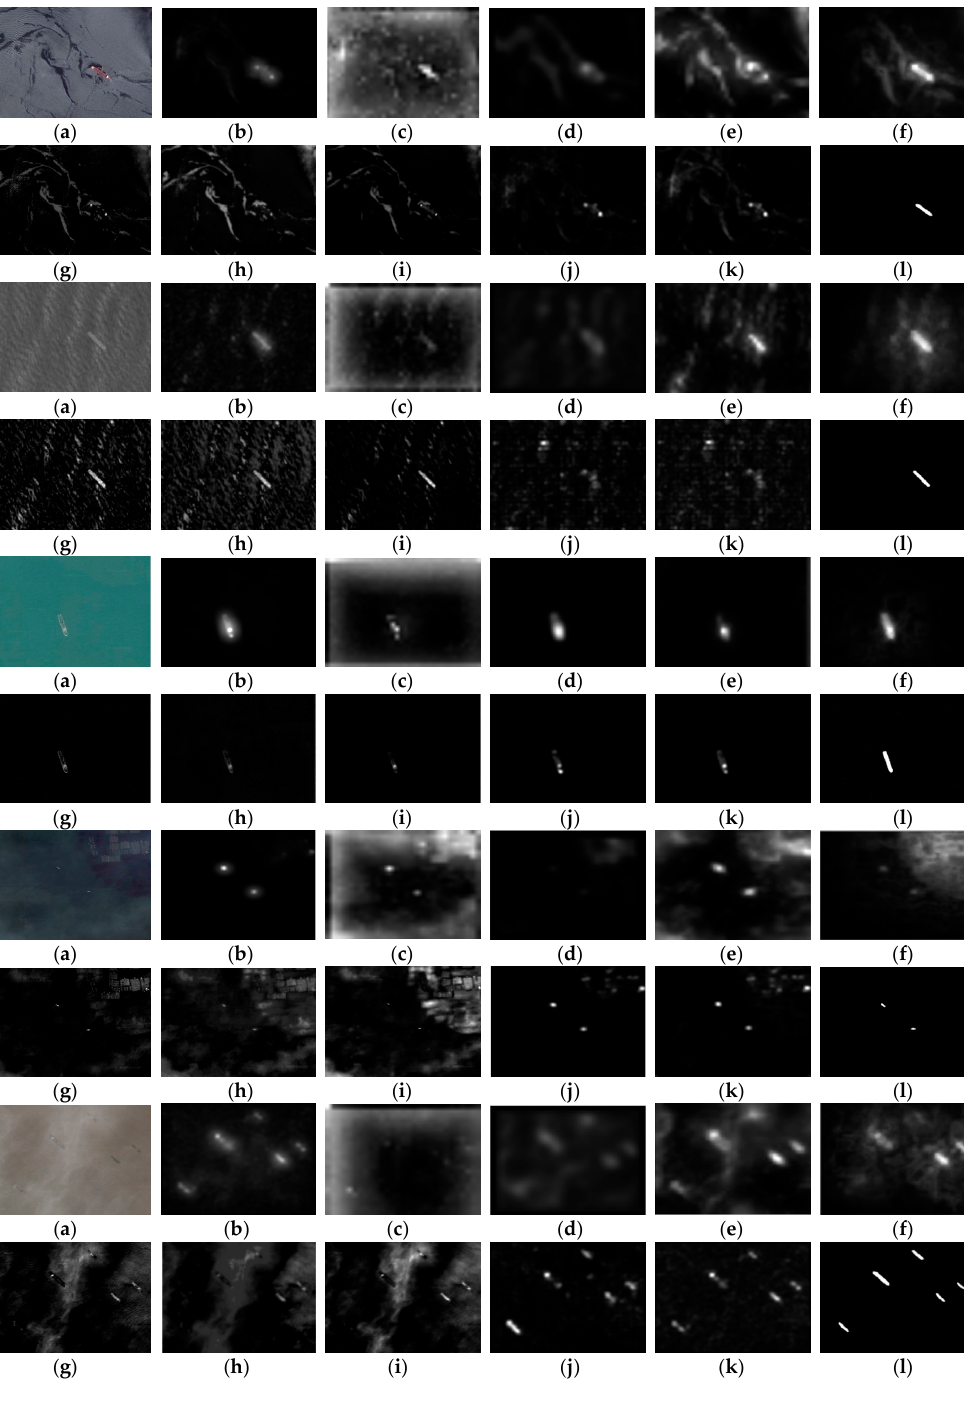
Figure 11. Visual comparison of saliency maps: ( a ) input image; ( b ) CSM; ( c ) ITTI (devised by Itti et al.); ( d ) Attention based on Information Maximization (AIM); ( e ) Graph-Based Visual Saliency (GBVS); ( f ) Goferman; ( g ) Linear Contrast (LC); ( h ) Histogram Contrast (HC); ( i ) Frequency-Tuned Saliency (FT); ( j ) Spectral Residual (SR); ( k ) PQFT; (l) ground-truth.